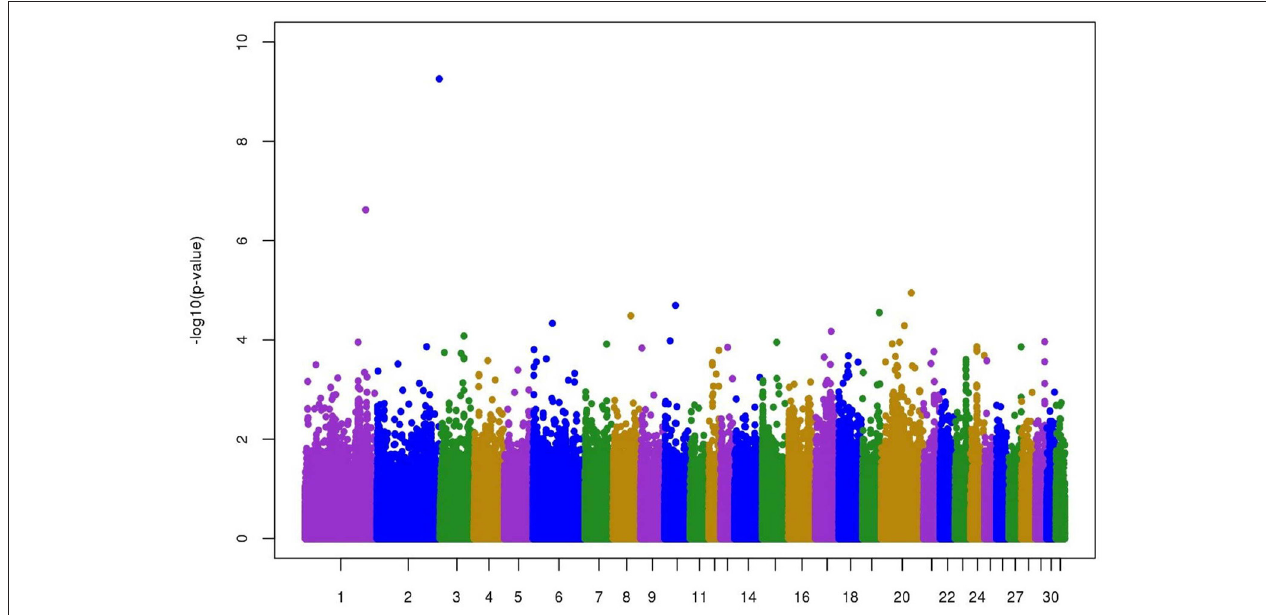
FIGURE 2 | Manhattan plot of -log10(P) of individual SNP effects on longevity in jumping